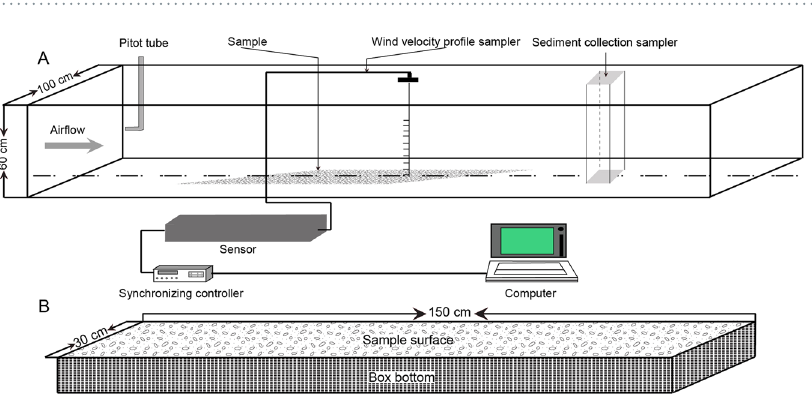
Figure 4. Schematic diagram of ( A ) the wind tunnel and sample arrangement during the wind tunnel experiment, and ( B ) the surface